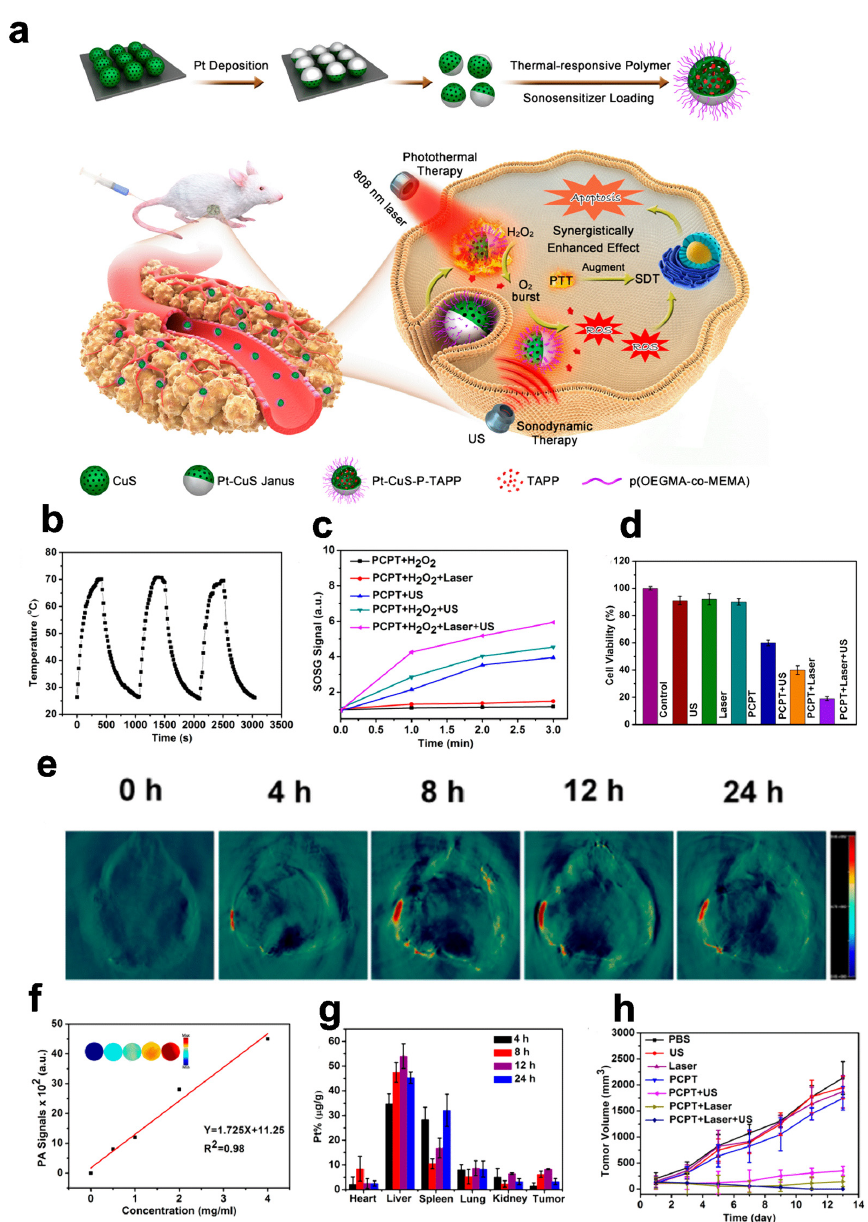
Figure 3. Pt-CuS Janus for PAI. ( a ) Schematic illustration of the main synthesis procedures and antitumor mechanism of PCPT. ( b ) Photothermal stability of the Pt-CuS solution. ( c ) The production of 1 O 2 in the presence of PCPT (50 ppm) under different conditions. ( d ) The viability of CT26 cells after different treatments. ( e ) In vivo PA imaging of tumor-bearing mice. ( f ) In vitro PA imaging of different concentrations of Pt-CuS NPs. ( g ) Biodistribution of Pt in the tumor and main organs after injection of PCPT. ( h ) Tumor volume change curves during therapy. Reproduced with permission from Ref. [104]. Copyright © 2019 American Chemical Society.